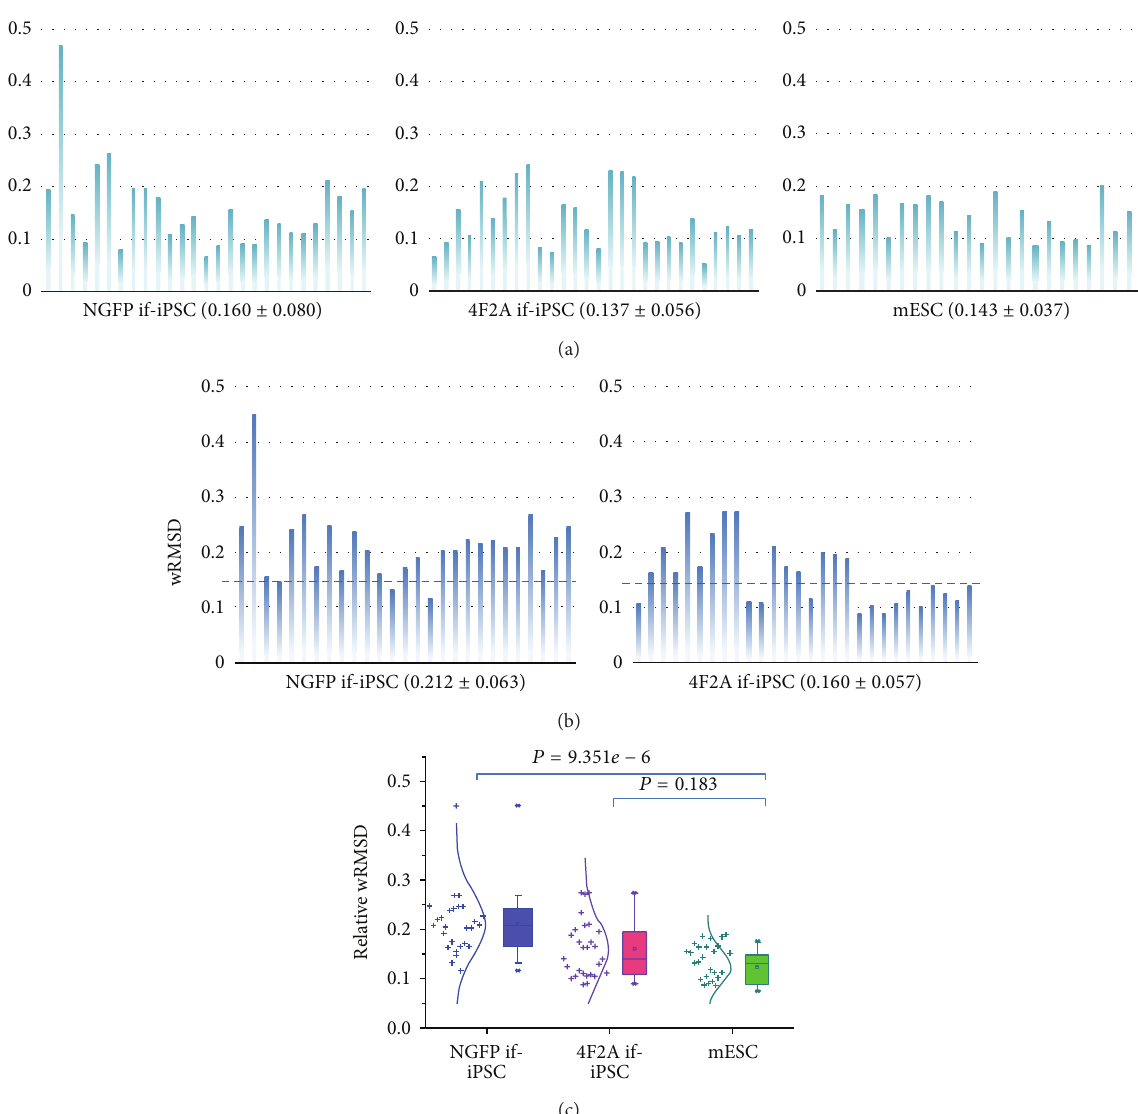
Figure 3: wRMSD distributions of NGFP if-iPSC and 4F2A if-iPSC colonies relative to those of mESC colonies. (a) The distribution of weighted root mean square deviation (wRMSD) of individual colonies in each group. The deviation of each if-iPSC colony’s GEP from the mean GEP of each group was estimated using wRMSD. Numbers in parentheses denote mean ± standard deviation. The closer the wRMSD is to zero, the closer the GEP is to the mean GEP of its own group. (b) Relative wRMSD obtained by calculating the deviations of the gene expression in each NGFP if-iPSC and 4F2A if-iPSC colony from the mean GEP of the mESC group. Dashed red line in each panel indicates the mean wRMSD (0.143 ± 0.037) of the mESC group as the reference. (c) Statistical difference between the groups. The 𝑃 values between different colony groups are indicated above ( 𝑡 -test). The wRMSDs of individual colonies are shown as crosses together with a normal distribution curve on the left of each box plot. Box whiskers indicate the range from 5% to